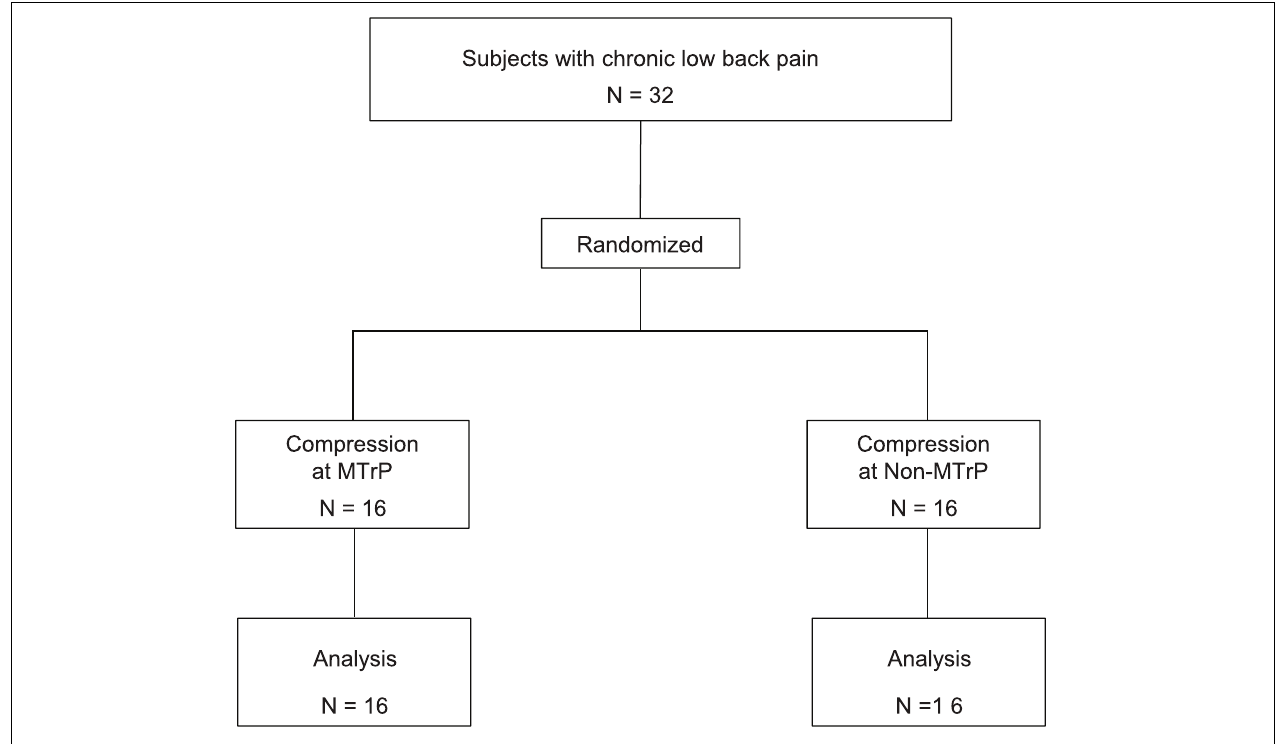
FIGURE 1 | Participant flow